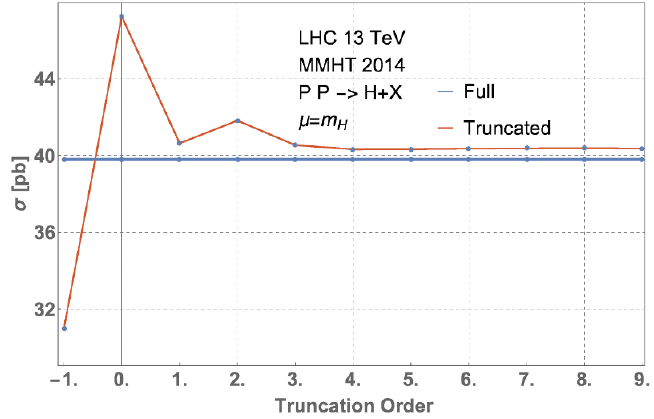
Figure 1. Inclusive production probability for a Higgs boson as a function of the truncation order of the threshold expansion for the NNLO correction (red). The blue line represents the unexpanded NNLO inclusive cross section.